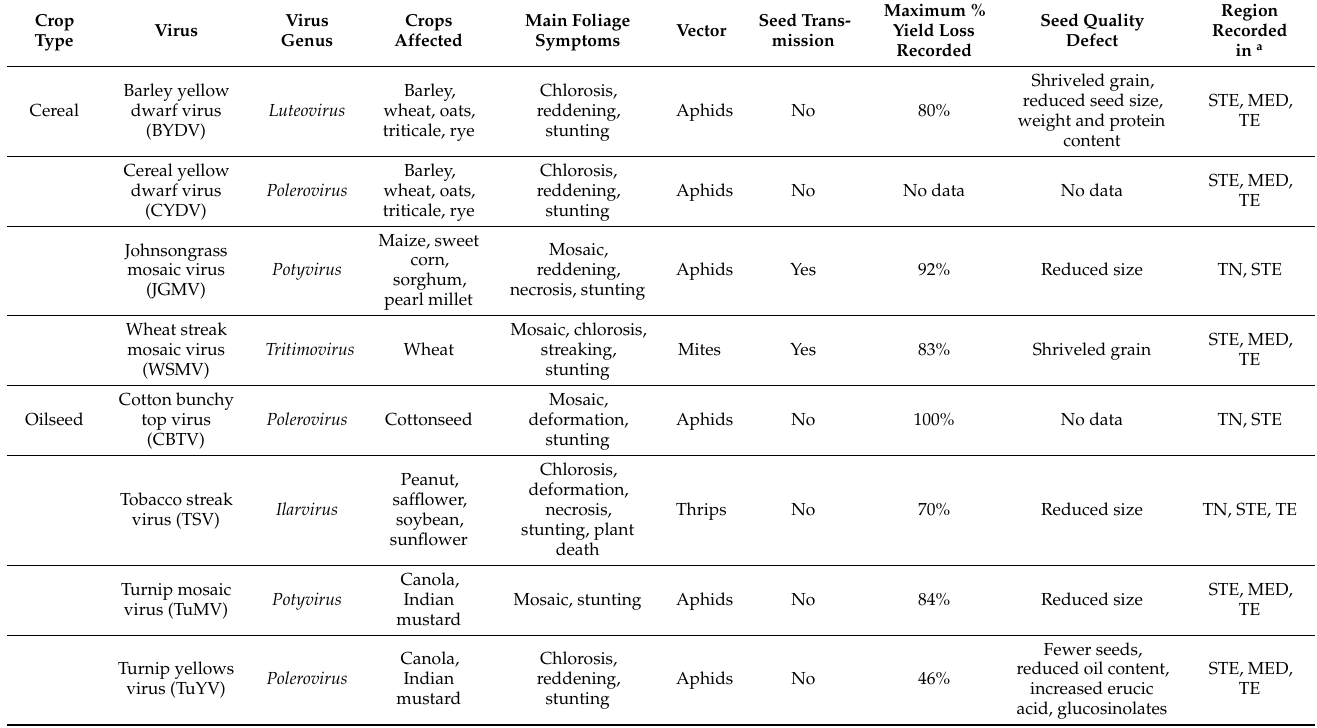
Table 2. The Most important viruses that infect cereal and oilseed crops in